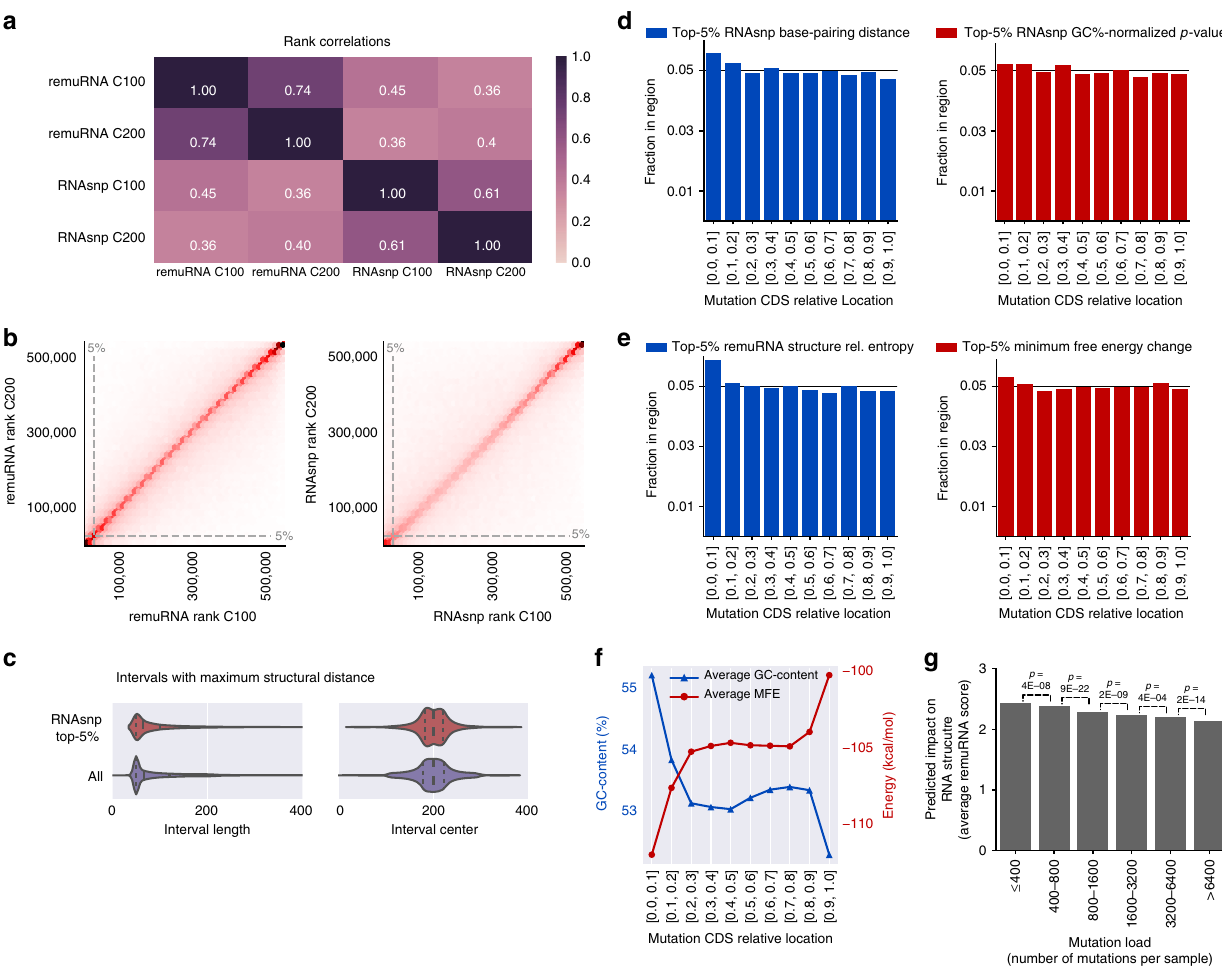
Fig. 5 RNA secondary structure analysis of synonymous mutations. a Spearman ’ s rank correlation between the selected scoring metrics remuRNA score (relative entropy of ensembles of structure formations) and RNAsnp (base-pairing distance p -value) for two different context lengths C100 ( − / + 100 nt) and C200 ( − / + 200 nt). b Correlation of the mutation rankings of secondary structure aberrations for the two context lengths C100 or C200 for remuRNA (left) and RNAsnp (right). c For each input sequence and mutation, RNAsnp reported the subsequence interval accommodating the largest structural change in terms of maximum base-pair probability distance. For the context length of − / + 200 nt around each SNP, the distributions of the interval lengths (left) and the middle positions of the intervals (right) are depicted. d Fraction of synonymous mutations with the strongest secondary structure aberrations (top 5th percentile of all synonymous mutations calculated by RNAsnp 44 ) within each coding sequence region based on base-pairing distance (left) or p -value of base-pairing distance normalized for GC-content (right) are depicted for all synonymous mutations relative to their position in the coding region (10% bins). If mutations would be uniformly distributed along the transcript, the fraction in each region would be 0.05. e Fraction of synonymous mutations with the strongest secondary structure aberrations (top 5th percentile of all synonymous mutations calculated by remuRNA) within each coding sequence region based on relative entropy (left) or minimum free energy change (right) are depicted for all synonymous mutations relative to their position in the coding region (10% bins). Again, the expected fraction of a random distribution would be 0.05 for each region. f Average GC-content and minimum free energy (MFE) of the RNA secondary structure associated with the context window of 200 nt upstream and downstream of the synonymous mutation are depicted for all synonymous mutations relative to their position in the coding region (10% bins). g The predicted impact on the RNA secondary structure (average of remuRNA score) is depicted for different bins of mutation loads with a higher remuRNA score for synonymous mutations found in samples with lower number of mutations in total (signi fi cance: t